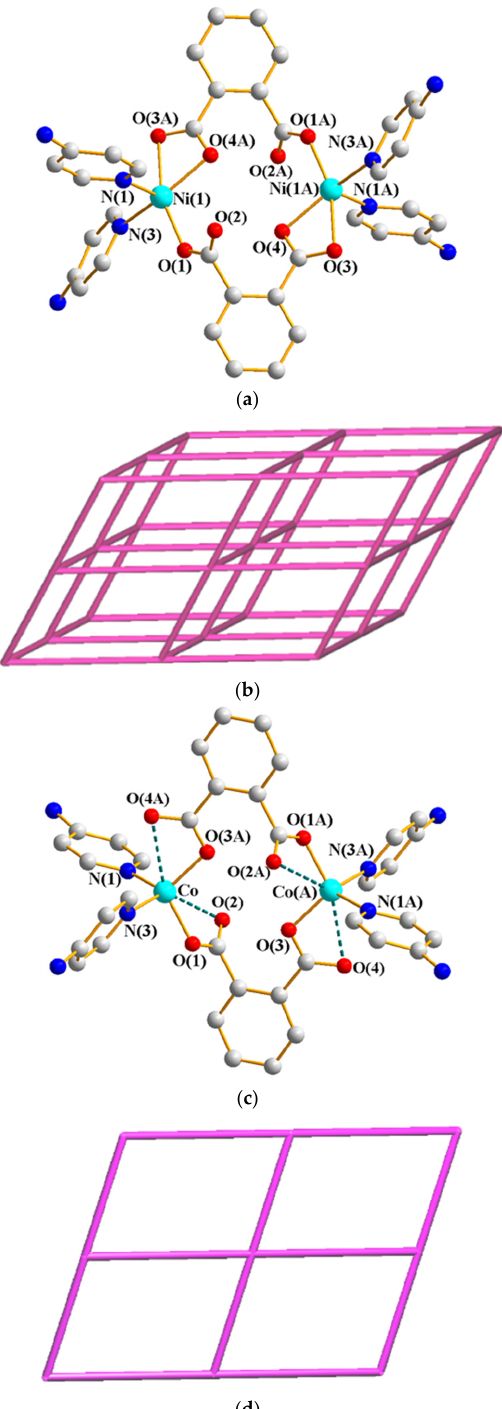
Figure 3. ( a ) The dinuclear metallocycles of 3a . Symmetry transformations used to generate equivalent atoms: (A) 1 − x, 2 − y, 1 − z. ( b ) A drawing showing the pcu topology for the 3D supramolecular structure of 3a . ( c ) The dinuclear metallocycles of 3b . Symmetry transformations used to generate equivalent atoms: (A) 2 − x, 1 − y, 2 − z. ( d ) A drawing showing the sql topology for the 2D supramolecular structure of 3b